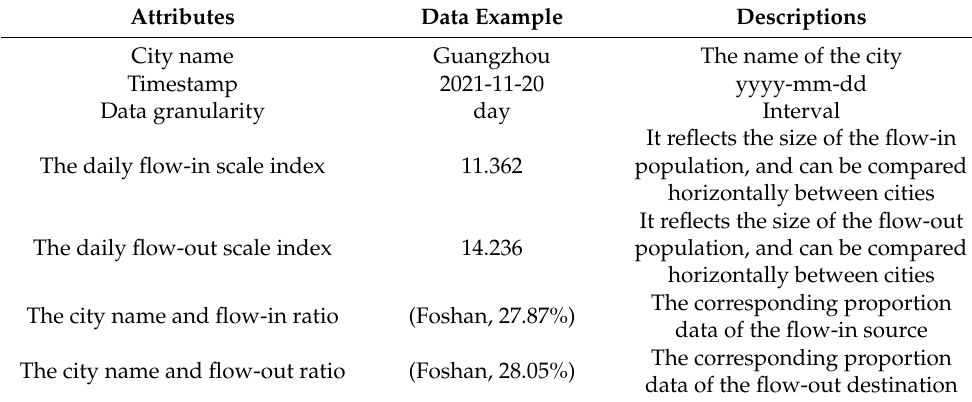
Table 1. Attributes of Baidu migration